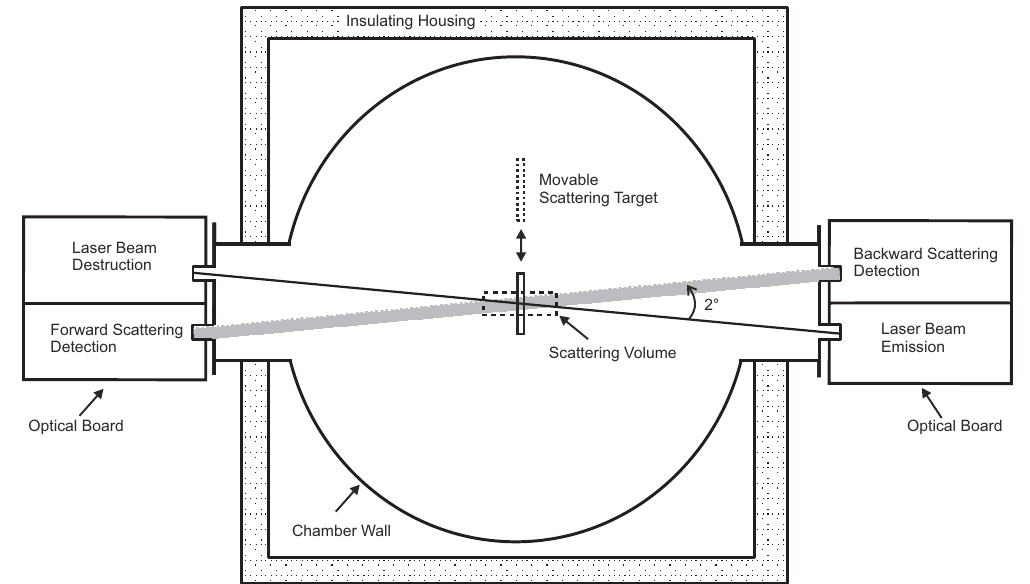
Fig. 1. Horizontal cross section view of the first AIDA level showing the scattering plane of the SIMONE instrument. The SIMONE instal- lation boards are directly mounted on two opposite AIDA flanges that were extended to beyond the insulating housing of the chamber. Note that the scattering target is not moving horizontally as indicated in the scheme, but vertically with respect to the scattering plane.